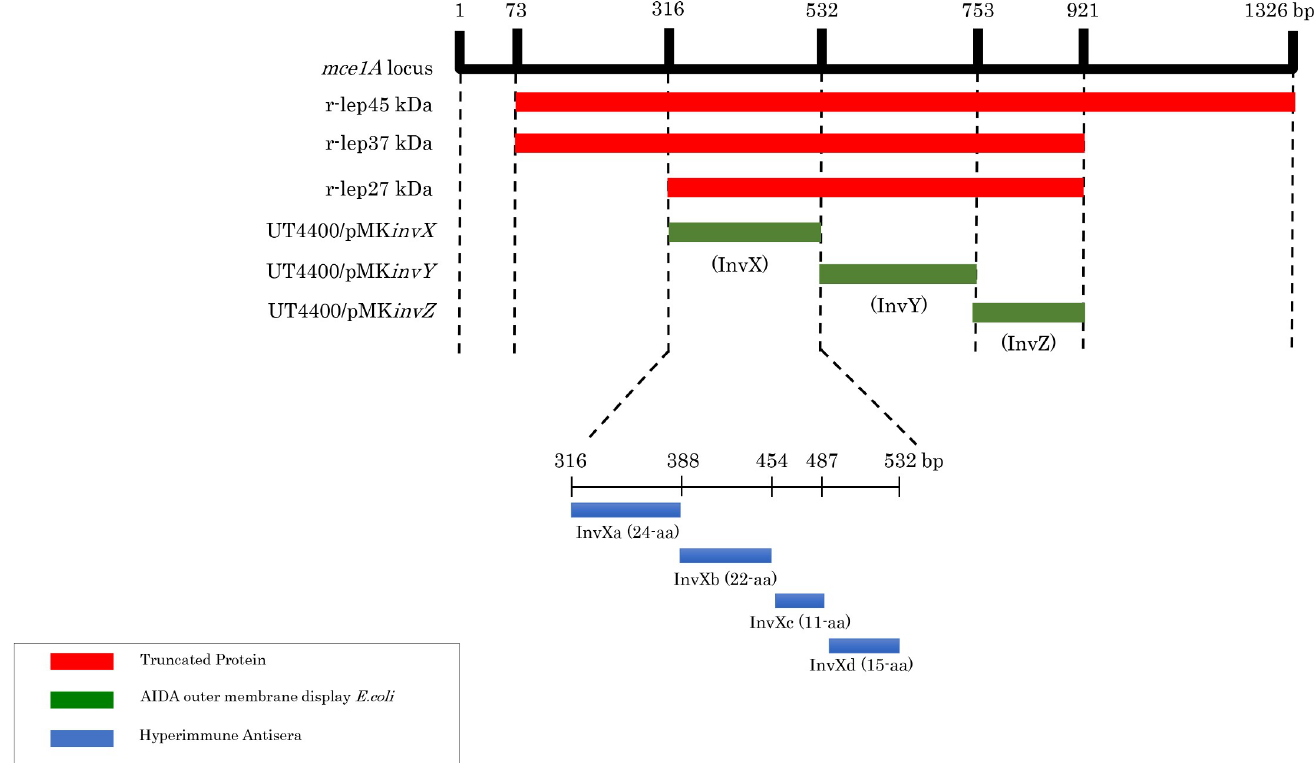
Fig 1. r-Mce1A truncated protein regions expressed on E . coli , regions externally expressed using AIDA method, and regions for which hyperimmune antisera is prepared. Using r-lep45 kDa protein encoded in the entire region of Mce1A minus signal sequences (73–1326 bp) as a reference, the protein with its C terminus truncated to 921 bp (amino acid-307) was denoted as r-lep37 kDa protein. Where the N terminus of r-lep37 kDa is truncated to 315 bp (amino acid-105), the resultant construct was denoted as r-lep27 kDa protein. Furthermore, 316–921 bp region was divided into 316–531 bp, 532–753 bp, and 754–921 bp, and recombinant E . coli in which these regions are externally expressed using AIDA method were prepared. InvX region (316–531 bp) was further divided into invXa (316–387 bp), invXb (388–453 bp), invXc (454–486 bp), invXd (487–531 bp). Hyperimmune antisera was prepared by synthesizing peptide for each InvX region (Sigma Custom Peptide Service), conjugate with Keyhole Limpet Hemocyanin (KLH), and inoculating into